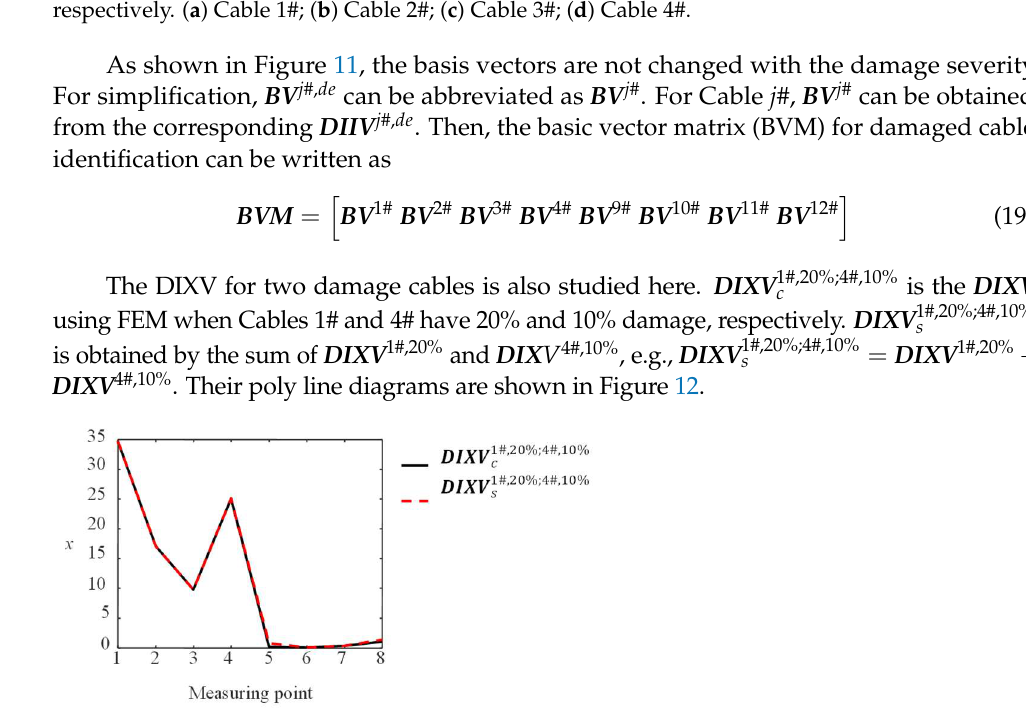
Figure 12. Comparison of DIIV 1#,20%;4#,10% c obtained by FEM and DIIV 1#,20%;4#,10% s obtained by superposition.